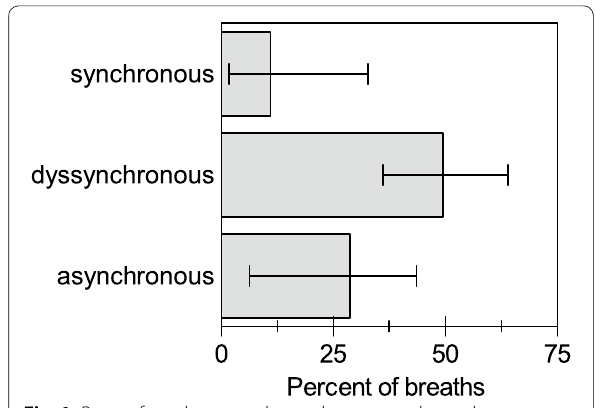
Fig. 1 Rates of synchronous, dyssynchronous and asynchronous breaths as classified by the automated analysis. Columns are median, and bars are interquartile